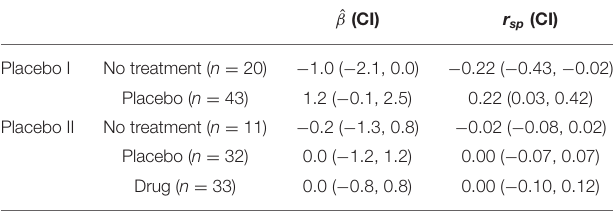
TABLE 2 | Relationships between baseline pain variability and relief by